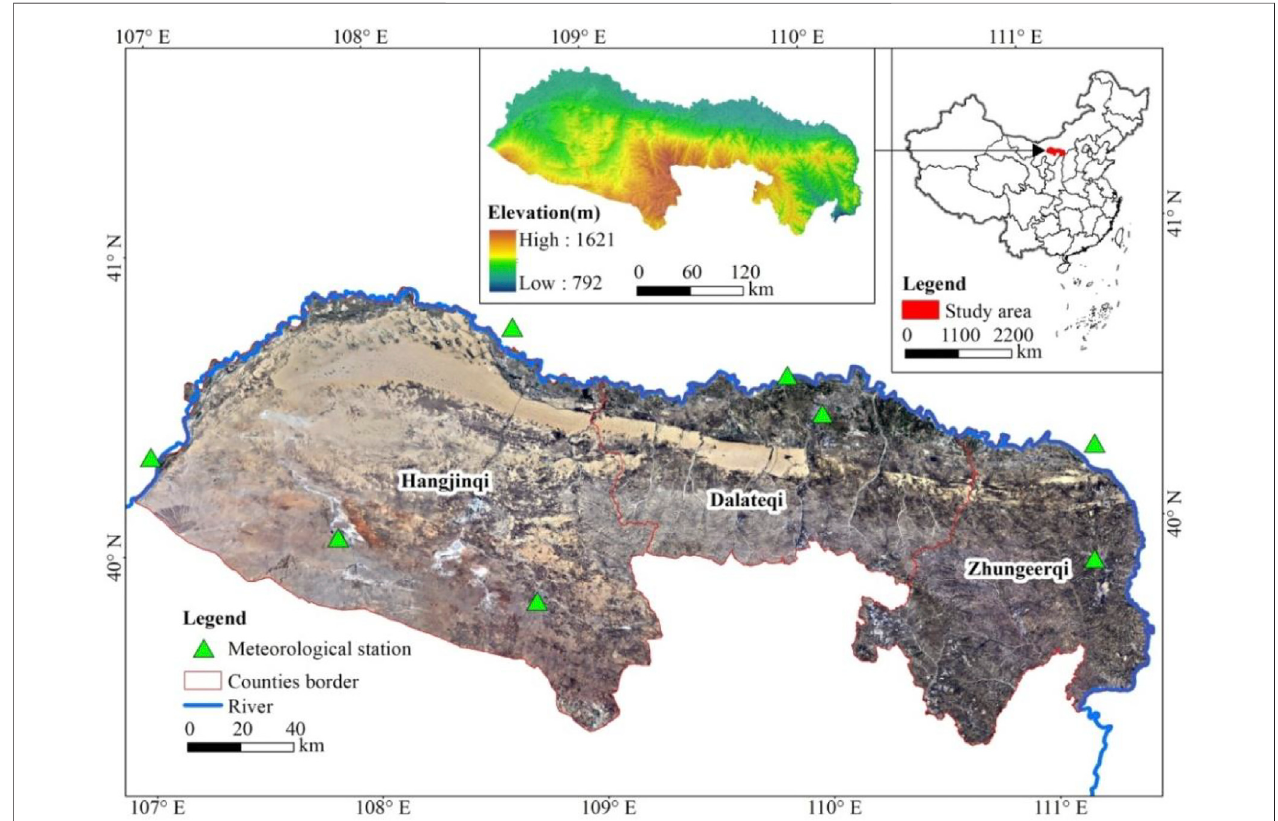
FIGURE 1 | Location and elevation map of the study